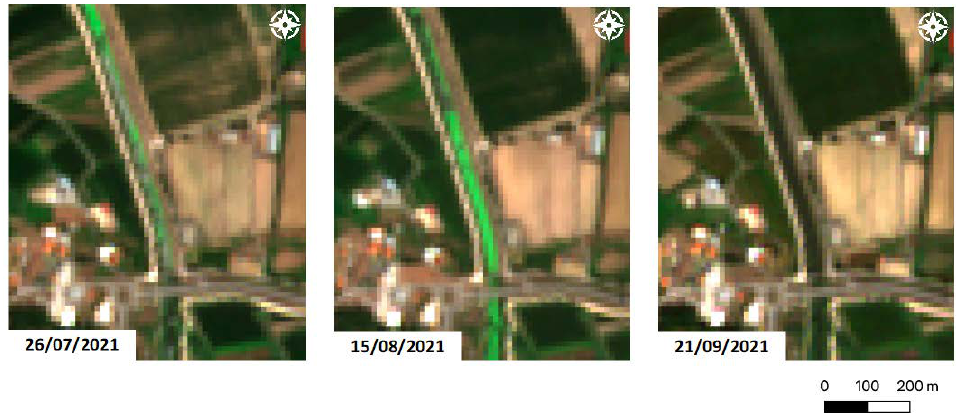
Figure 3. Illustration of the temporal (seasonal) variation in the presence of invasive aquatic plants ( Lemna minor ) in a section of the Lis River, Portugal (Figures 1b and 2). Images are from the Sentinel-2 satellite (10 m spatial resolution).